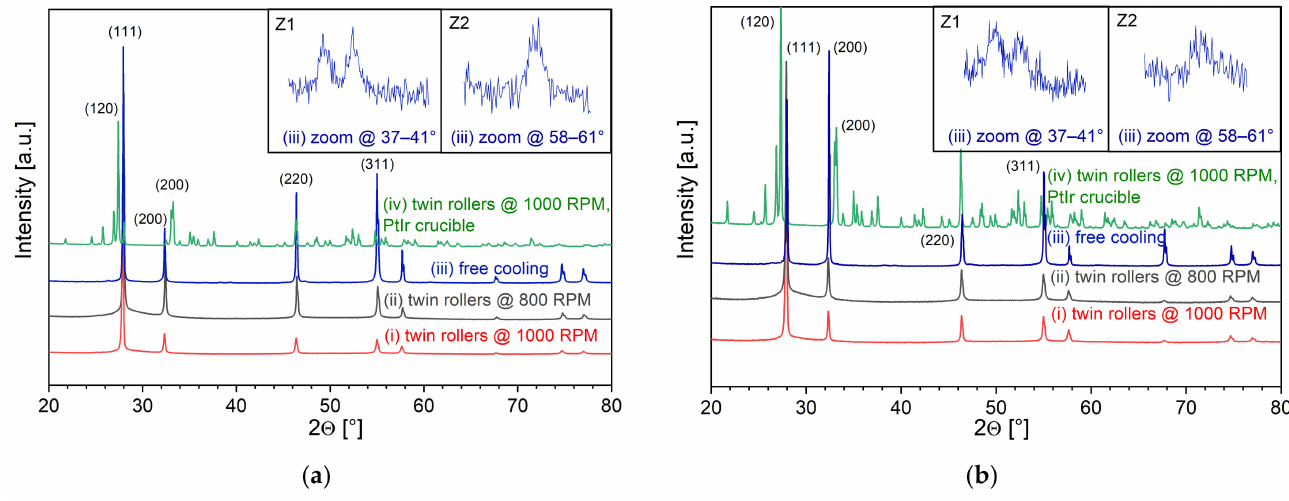
Figure 1. ( a ) XRD patterns of samples melted in ceramic crucible at 900 ◦ C and prepared by: (i) twin roller quenching at 1000 RPM (red line); (ii) twin roller quenching at 800 RPM (dark grey line); (iii) free cooling (blue line). Pattern (iv) refers to sample melted in PtIr crucible at 900 ◦ C (green line). ( b ) XRD patterns of samples melted in ceramic crucible at 1000 ◦ C and prepared by: (i) twin roller quenching at 1000 RPM (red line); (ii) twin roller quenching at 800 RPM (dark grey line); (iii) free cooling (blue line). Pattern (iv) refers to sample melted in PtIr crucible at 1000 ◦ C (green